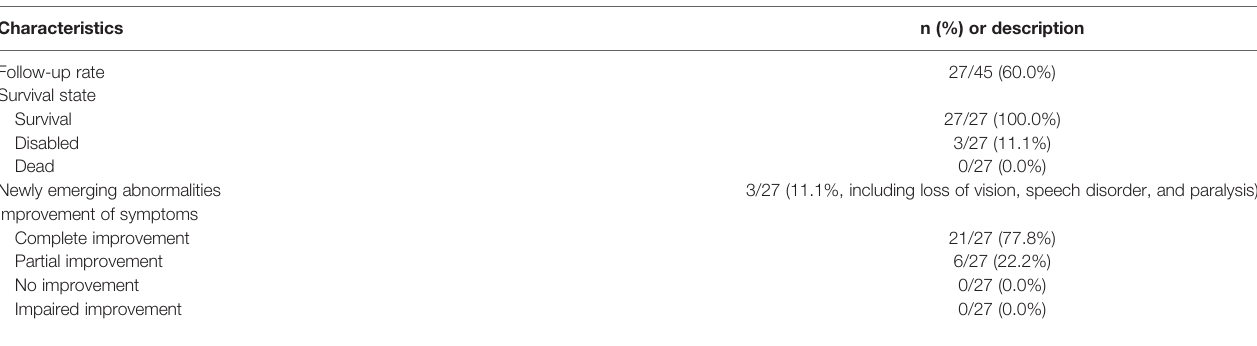
TABLE 4 | Prognosis of included patients via follow-up.